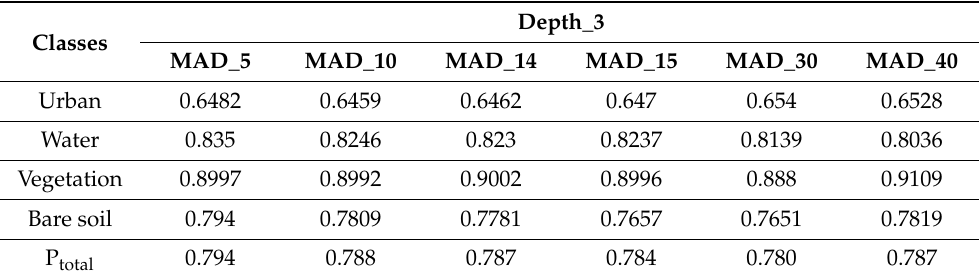
Table 15. Probabilities for classes and total probabilities of correct classification for depth 3 and different MAD.